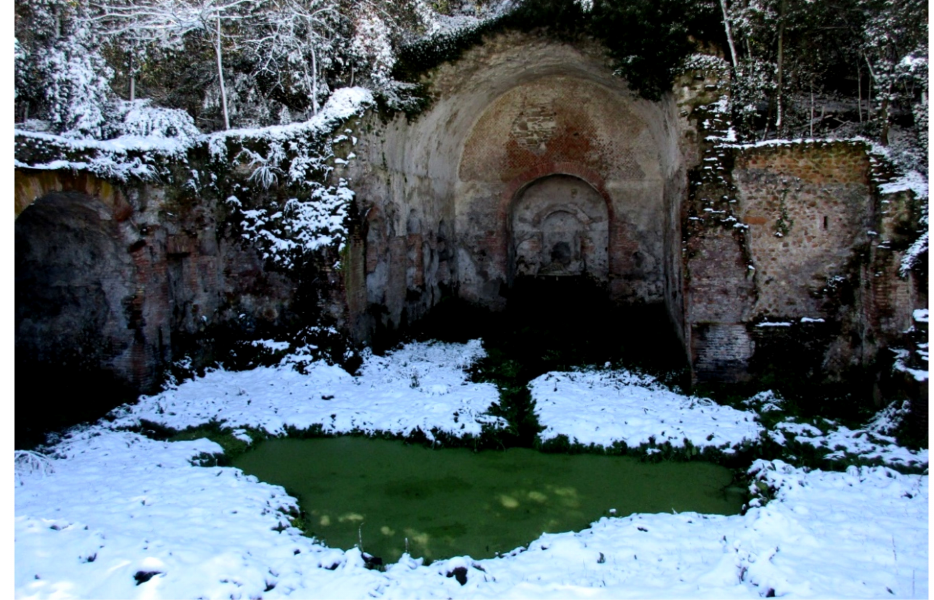
Figure 77. Lemna minuta in aquatic habitat of Egeria nymphaeum during snowfall in February 2018 (Caffarella